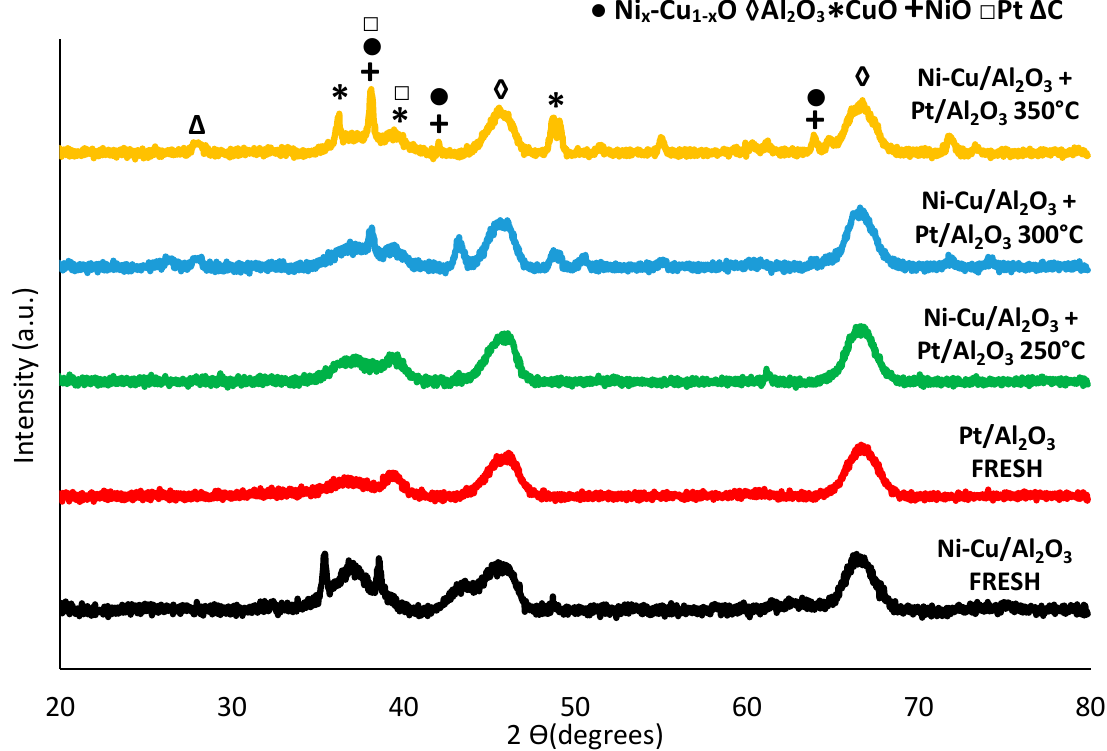
Figure 12. XRD of the fresh and recovered Ni ‐ Cu/Al 2 O 3 + Pt/Al 2 O 3 .